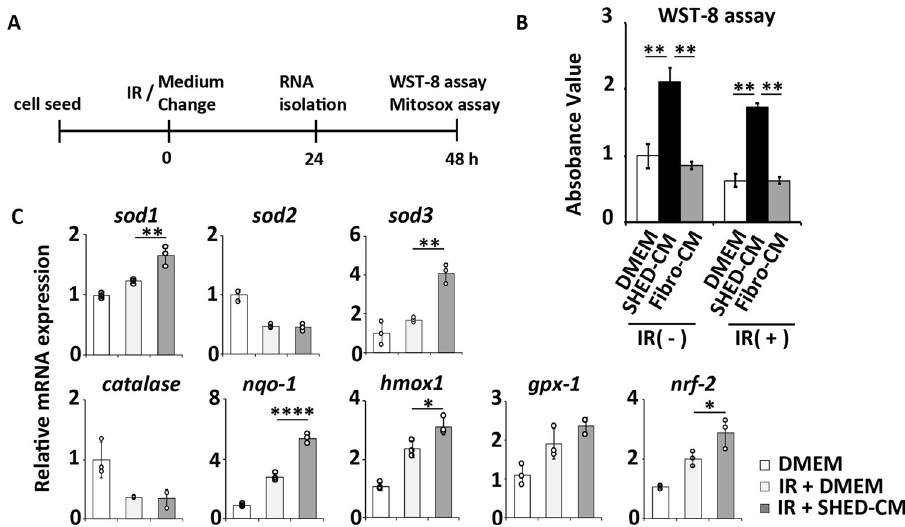
Figure 6. SHED-CM enhances cellular proliferation and activates the endogenous antioxidant system of the irradiated human acinar cell line. ( A ) Experimental protocol: Time course of the SHED-CM treatment in vitro. The human acinar cell line, NS-SV-AC, was irradiated with 5 Gy, and subsequently cultured with SHED-CM or Fibro-CM. ( B ) Quantitative analysis of the WST-8 assays 48 h after irradiation. ( C ) Quanitative real-time polymerase chain reaction analysis of the indicated mRNAs 24 h after irradiation. The results are expressed relative to the level in the DMEM-treated cells. Comparisons between groups were analyzed using an ANOVA with Tukey’s multiple comparison test (n = 3). Data are represented as mean ± SD (* p < 0.05, ** p < 0.01, **** p < 0.0001). CM, conditioned medium; Fibro, fibroblast; IR, irradiation; SHED, stem cells from human exfoliated deciduous